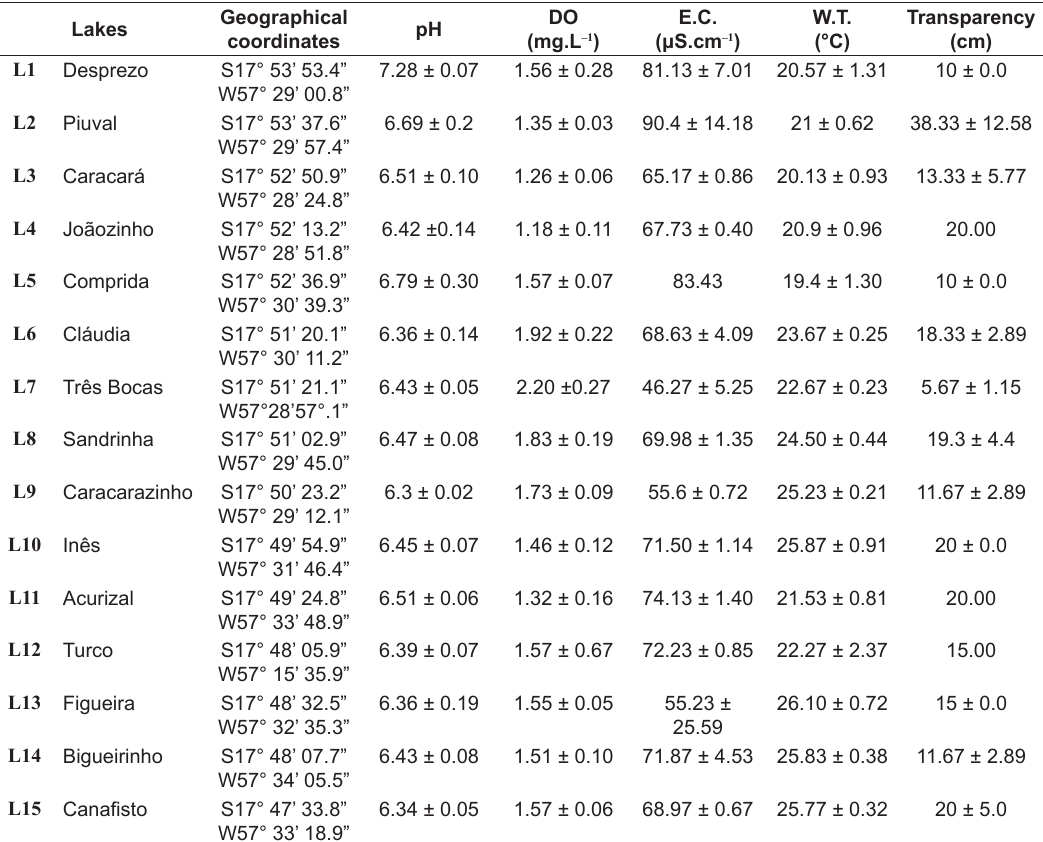
Table 1. Localization and average values of the physicochemical variables of the water of the 15 marginal lakes along the Paraguay River sampled in September of 2005.